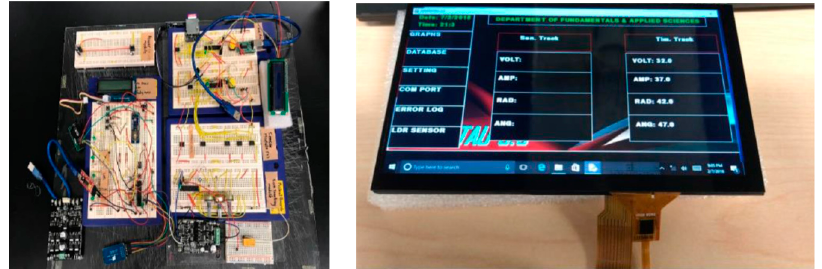
Figure 1. Final modular monitoring system.